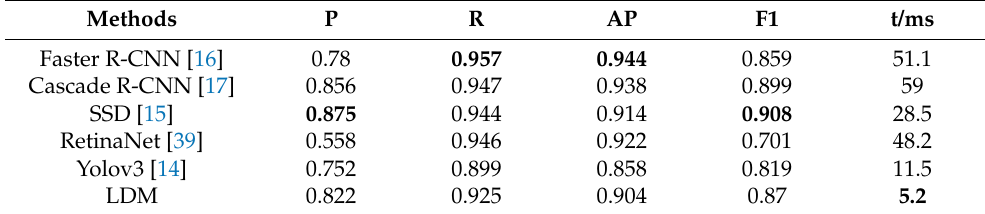
Table 2. Additional evaluation on SSDD.